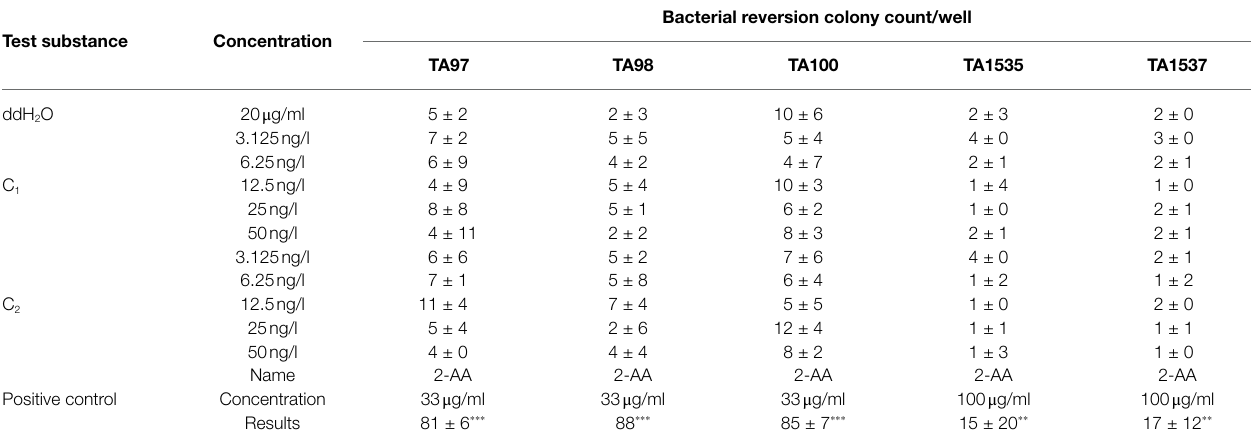
TABLE 9 | Results of 48 h bacterial reversion mutagenesis under metabolic activation conditions (+ rat S9; mean ± SD, n = 3).